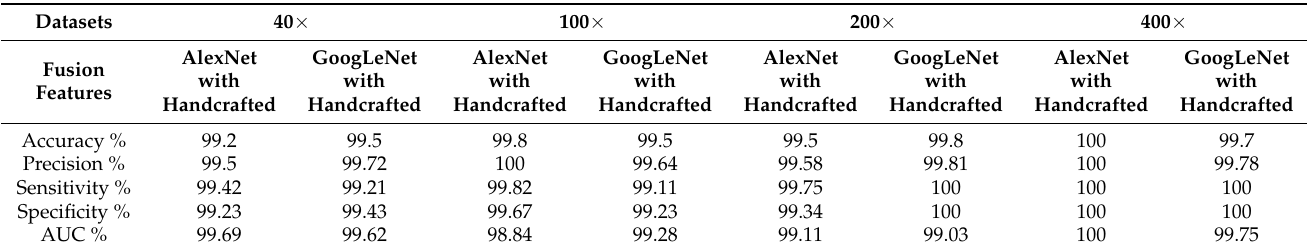
Table 6. ANN performance using fusion features for HI diagnosis of